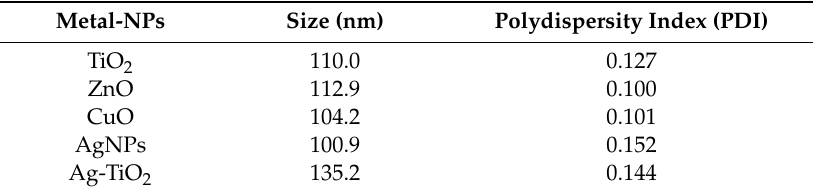
Table 1. Summary of the size (hydrodynamic diameter) and polydispersity index (PDI) values obtained for the synthetized nanoparticles.